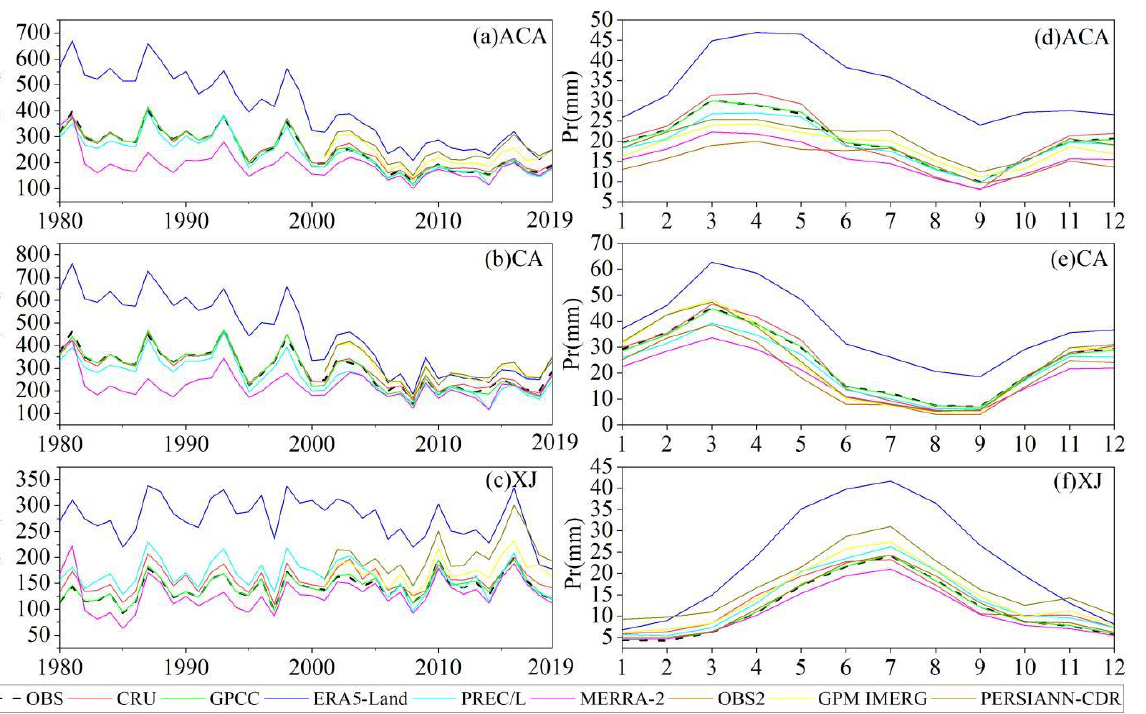
Figure 3. Variations in annual precipitation (left, a – c ) and monthly precipitation (right, d – f ) during 1980 – 2019 in arid Central Asia (ACA), Central Asia (CA), and Xinjiang of China (XJ).